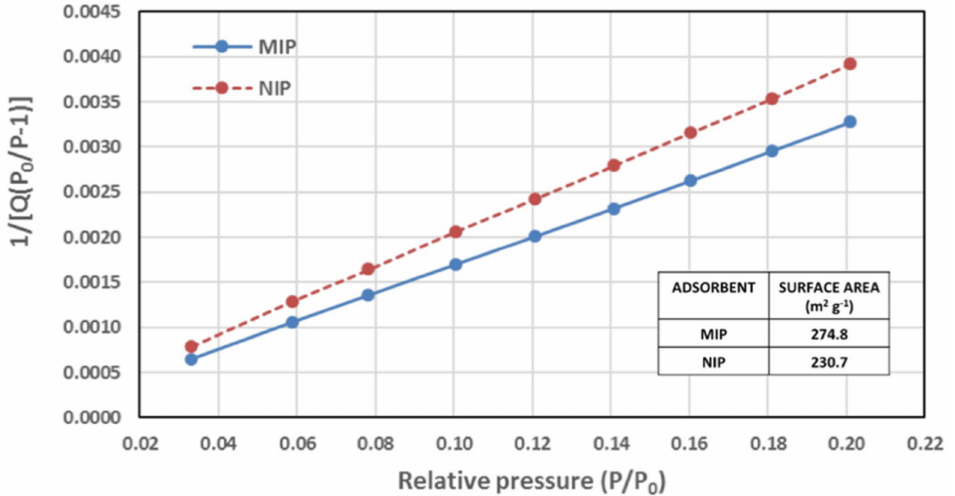
Figure 2. BET data of surface areas and linear plot obtained for molecularly imprinted polymer (MIP) and nonimprinted polymers (NIP) for N 2 at 77 K (Q is quantity adsorbed in cm 3